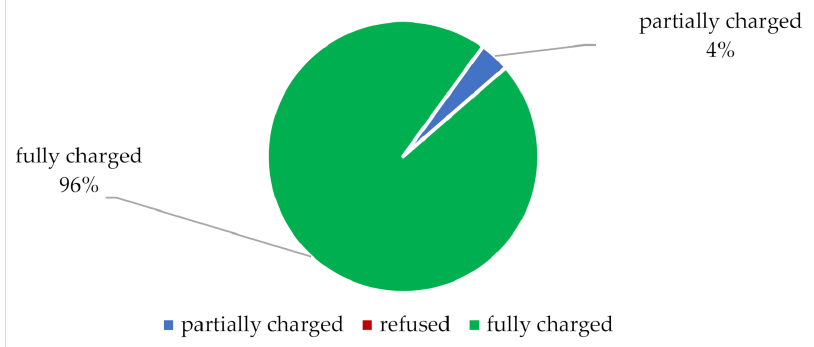
Figure 13. Success of recharging nonresidents in the case of using two